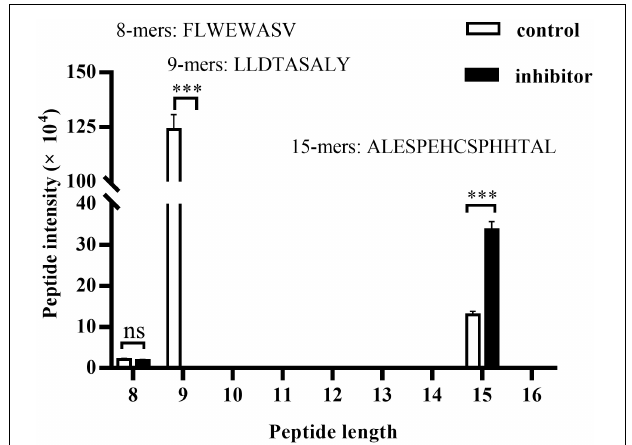
FIGURE 4 | ERAP1 trims HBcAg-specific peptides in HepG2.2.15 cells. HepG2.2.15 cells were treated with ERPA1-IN-1 (50 µ M) for 72 h. Cells were lysed, and the extracted protein was then analyzed by LC-MS/MS. The LFQ intensity of 8–16-mers residues was calculated and the peptides origin was identified by the MaxQuant (1.5.3.17) software via sequence-specific annotations based on the UniProt databases. ns, no significance; ∗∗∗ p <